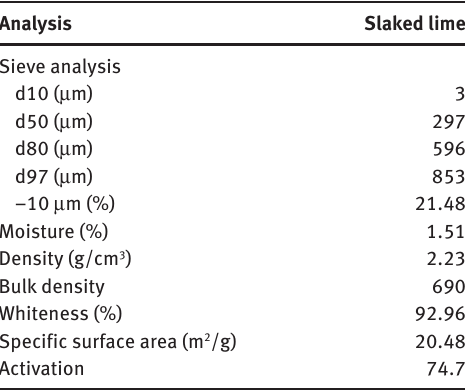
Table 4 Characterization test analysis of slaked